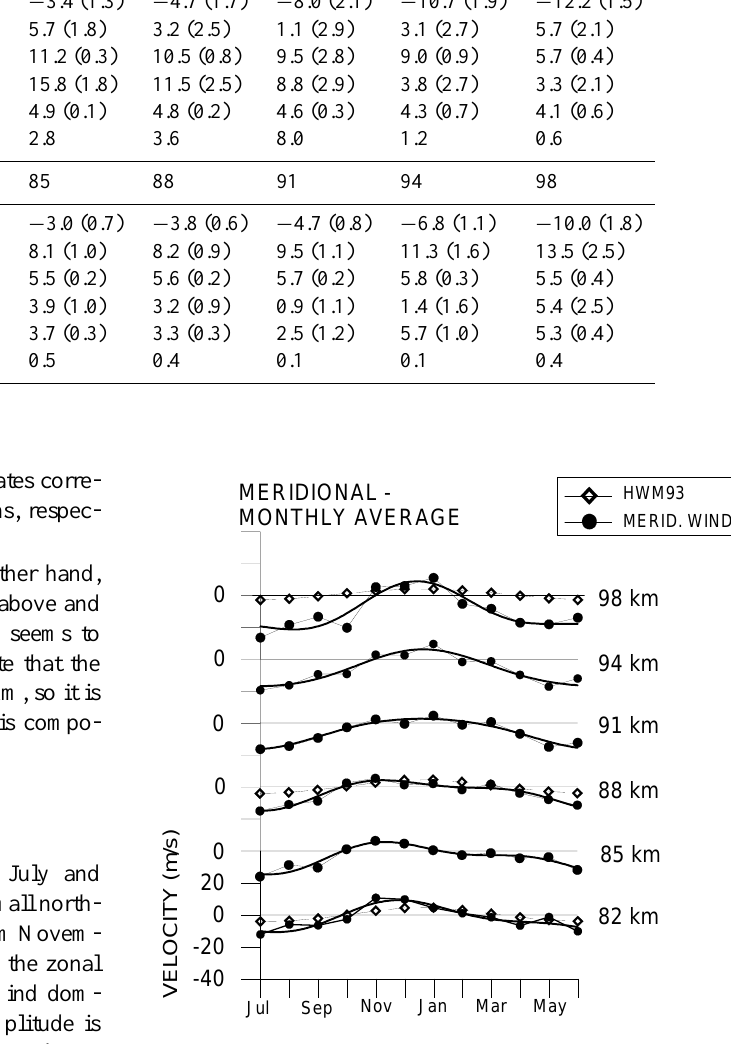
Fig. 2. Mean (monthly average) Meridional wind at heights from 82 to 98 km between July 2004 and June 2005 observed at Cariri (solid circles). Thin lines represent the fitting of annual and semiannual oscillations. Open diamonds are the winds provided by HWM93 for Cariri at 82, 88 and 98km. The RMS mean meridional and zonal winds, on average, were 37 m/s and 30 m/s, respectively. This means that the meridional wind variability is ∼ 23% higher than zonal wind during these 12 months of observation. This can be com- pared with the data for Cachoeira Paulista (Batista et al., 2004), where the variability of the zonal wind is much higher than that of the meridional one. That site is located at 22.7 ◦ S and 45 ◦